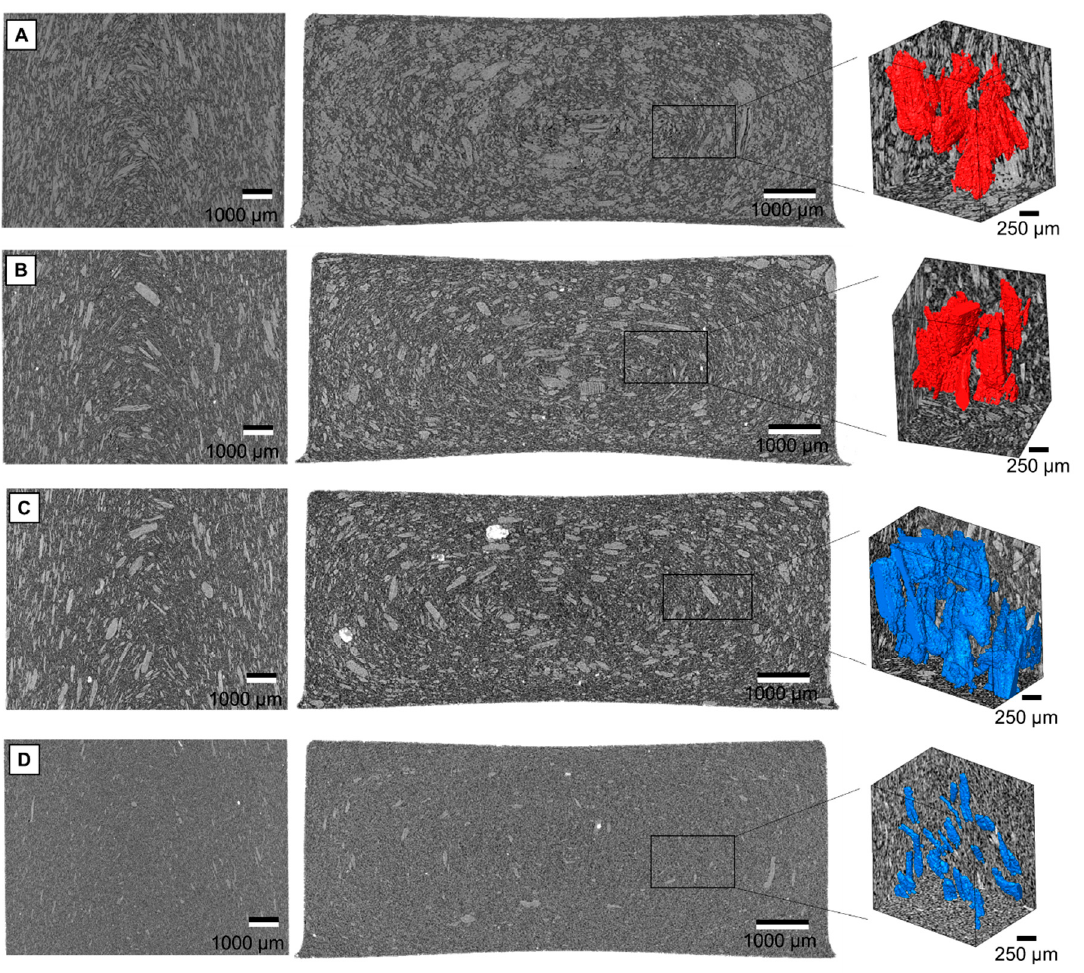
Figure 1. X-ray micro-computed tomography of four injection moulded WPC specimens based on RWPs [ A : R-WPC (B); B : R-WPC (S)] and RCPs [ C : WPC (PB), D : WPC (MDF)]. ( Left ) In-plane view of WPC samples showing wood particle/fibre length and alignment along the melt flow. Note the parallel aligned wood particles/fibres close to the surface layer, whereby within the inner core, the wood fibres/particles are aligned perpendicular to the melt flow. Wood particles/fibre are evenly distributed in all specimens but notably shorter and thinner within WPC (MDF). ( Middle ) Orthogonal view of specimens showing wood particle/fibre diameter and distribution. Note the high amount of thick wood fibre bundles within the reprocessed WPC ([ A , B ]). In addition to the wood particles bundles within the recycled WPC (PB) [ C ], high absorbing particulates (white) were observed. ( Right ) A 3D volume of wood tissue (blue) and wood fibre/particle agglomerations (red) has been isolated for closer inspection to highlight the spatial organization of the woody components. Scale bars = 1000 µm/250 µm.